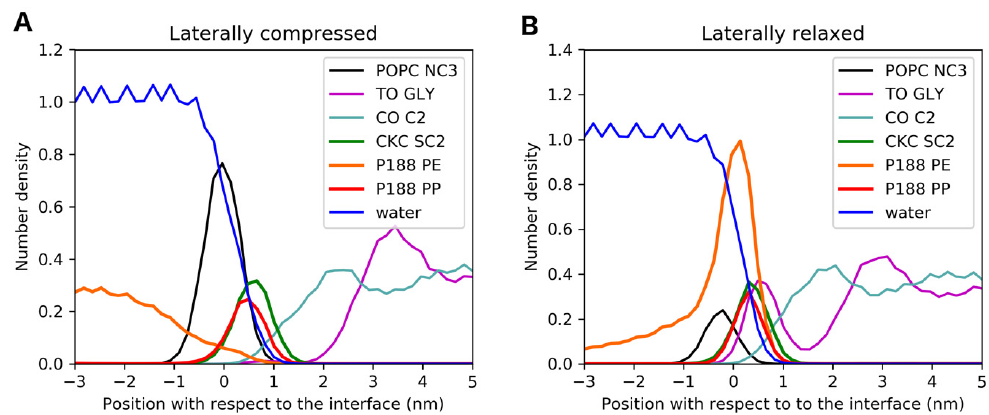
Figure 7. Density profiles of selected components of the TFLL model calculated in simulated films with area per polar lipid (APPL) = 91 Å 2 (designated as compressed) ( A ), and 354 Å 2 (designated as relaxed) ( B ) in the presence of both CKC and P188. Number densities of water, POPC polar headgroup (“POPC NC3”), triglyceride glycerol backbone (“TO GLY”), cholesterol oleate short chain terminal (“CO C2”), CKC polar headgroup (“CKC SC2”), P188 nonpolar core (“P188 PE”), and P188 polar tails (“P188 PP”) are depicted. The left-hand side of each graph represents the aqueous tear subphase, whereas the right-hand side corresponds to the nonpolar sublayer of TFLL. The data for the second lipid–air interface present in the simulation box (not shown here) are virtually the same. For comparison, the density profiles of the not supplemented system and the systems supplemented with CKC and P188 only are shown in Supplementary Figures S10–S12.